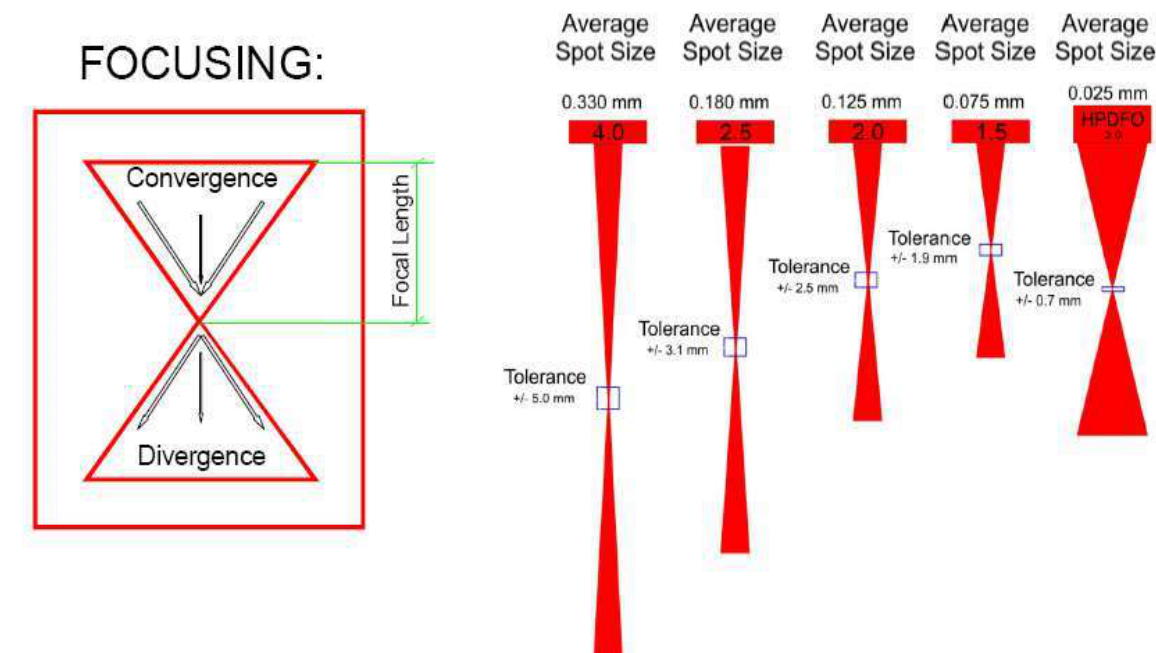
Figure 5. The lens is manually installed in front of the laser [40].